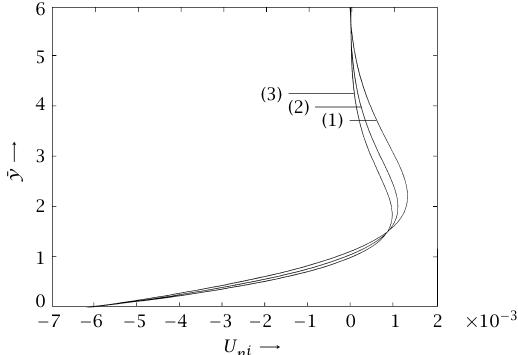
in the boundary p i